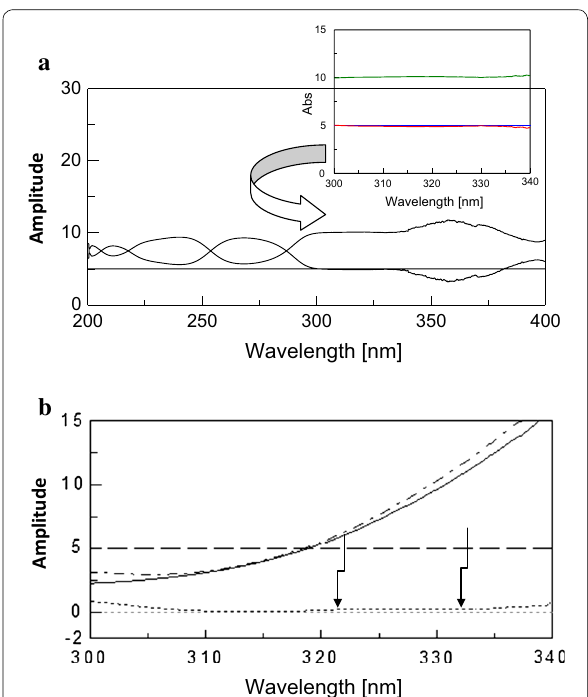
Fig. 11 a Ratio spectra of three binary mixtures of CAF and PAP in different concentrations using the sum of normalized spectra of CAF and PAP as double divisor showing the obtained constant region. b Ratio spectra of DRO ( solid line ), binary mixture of CAF and PAP ( dashed line ), PCT ( dotted line ) and their quaternary mixture ( dashed dotted line ), 5 μg/mL each using the sum of normalized spectra of CAF and PAP as double